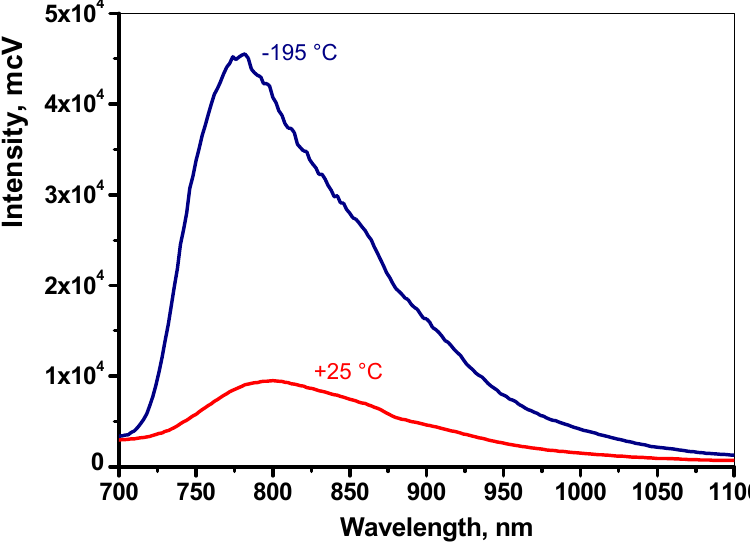
Figure 3. Photoluminescence spectra of copper(II) tetrafluorenyl-porphyrinate CuTFP in polystyrene film. Dark blue line: T= − 195 °C; red line: T = 25 °C [9].